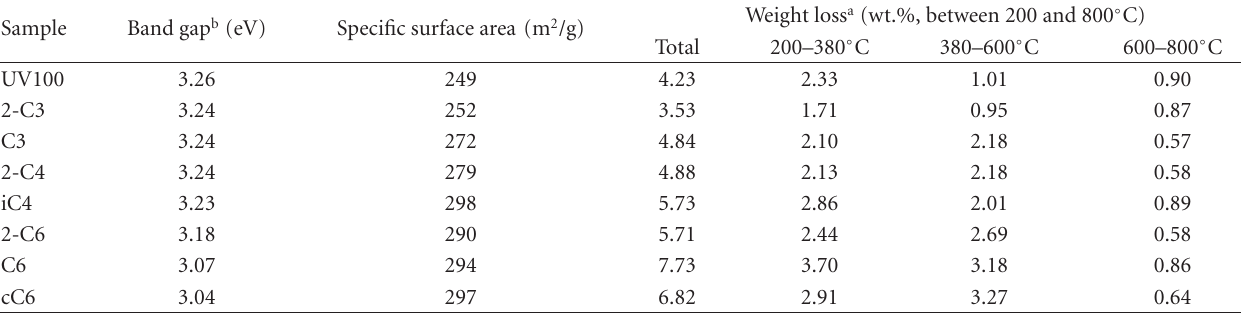
Table 1: Characterization of the band gap, specific surface area, and weight loss in TGA. Sample